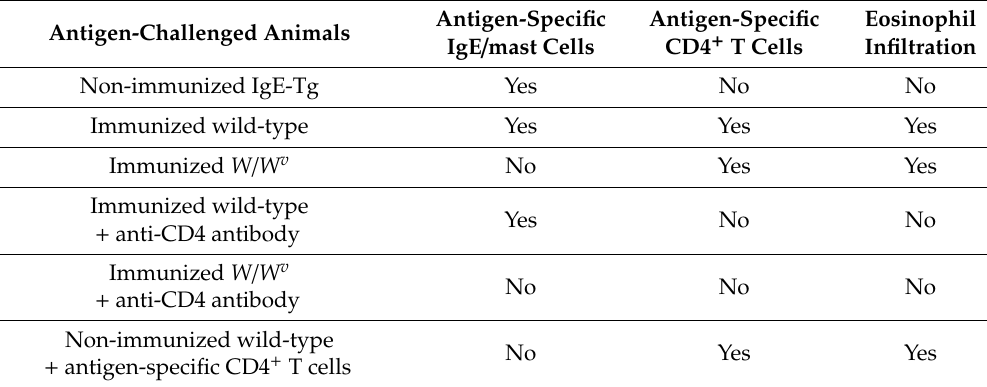
Table 1. Animal models showing involvement of IgE / mast cells and CD4 + T cells in allergic airway